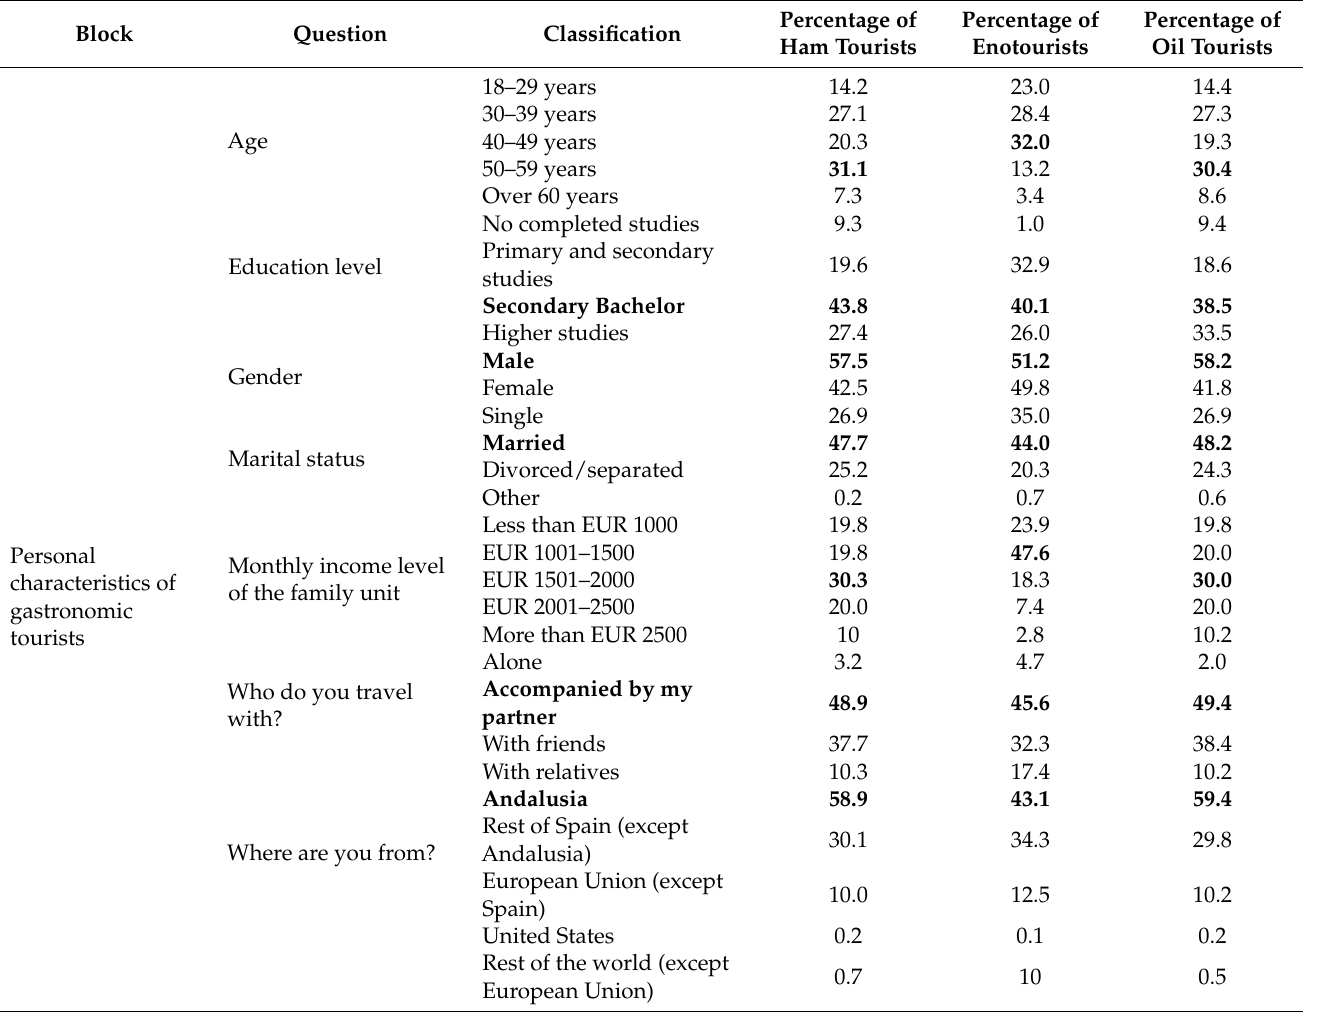
Table 3. Profile of gastronomic tourists in C ó rdoba